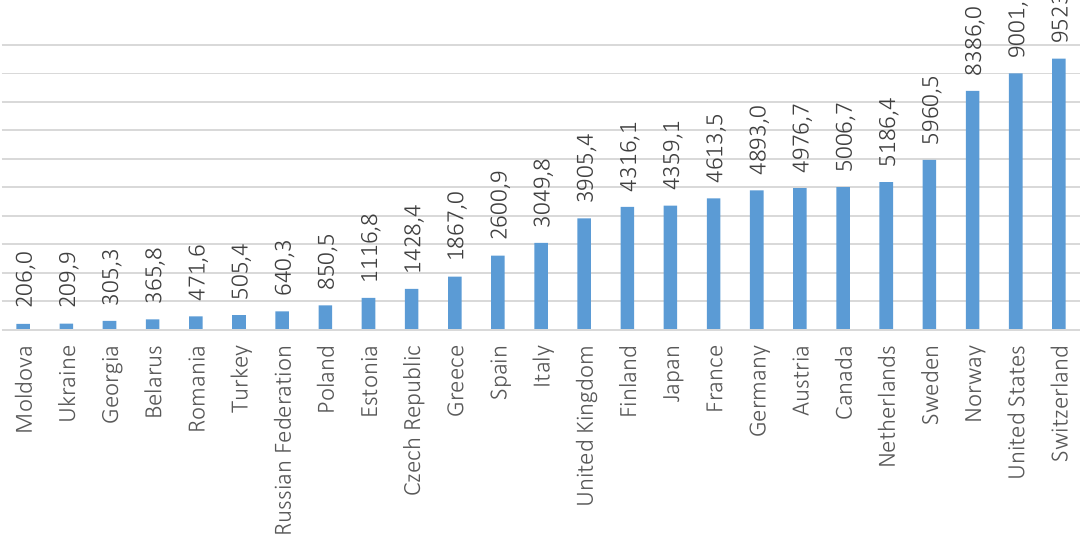
Figure 4. Average current health expenditure per capita (2010–2017), USD